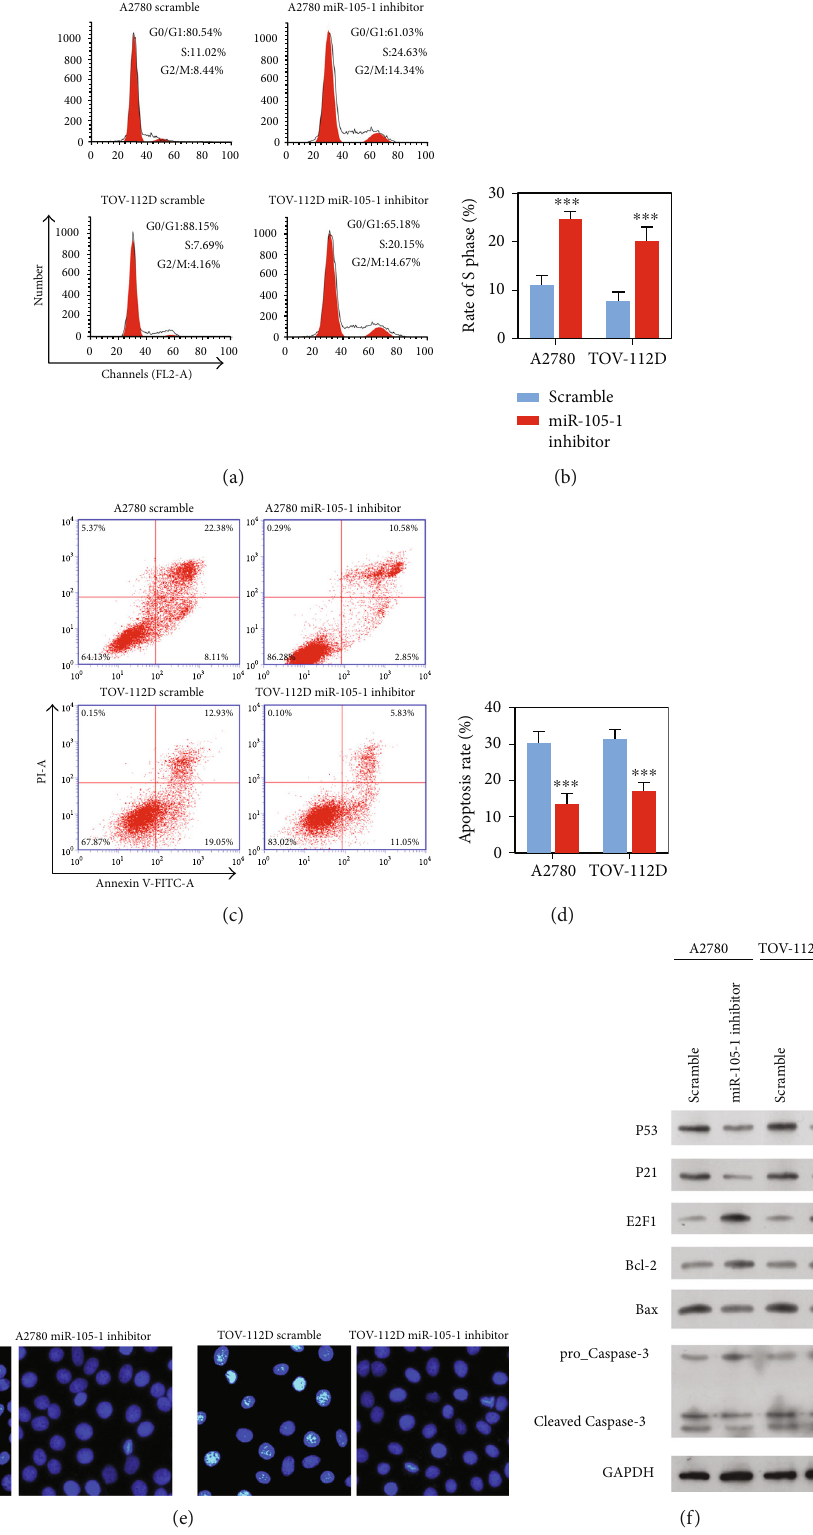
Figure 4: Downregulation of Hsa-miR-105-1 in OC cells induced resistance to cisplatin. A2780 and TOV-112D cells were transfected with the scramble or Hsa-miR-105-1 inhibitor and then stimulated with cisplatin (1 μ g/mL). (a, b) The cell cycle distributions of A2780 and TOV- 112D cells as detected by fl ow cytometry. (c, d) The percentages of apoptotic A2780 and TOV-112D cells were determined by annexin V- FITC/PI staining and fl ow cytometry. (e) Cell apoptosis was detected by Hoechst staining. (f) The levels of P53, P21, E2F1, Bcl-2, Bax, and caspase-3 protein expression were examined by western blotting. ∗∗∗ P < 0 : 01 and paired t